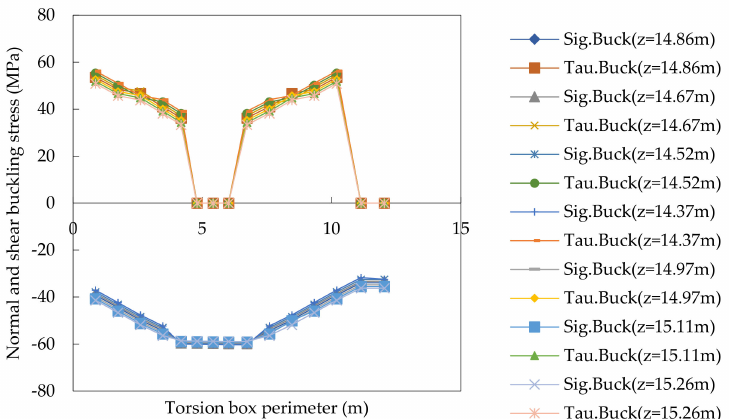
Figure 12. Evolution of elastic buckling stress, normal ( Sig.Buck ) and shear ( Tau.Buck ), along the perimeter of the torsion box for the different values of the height